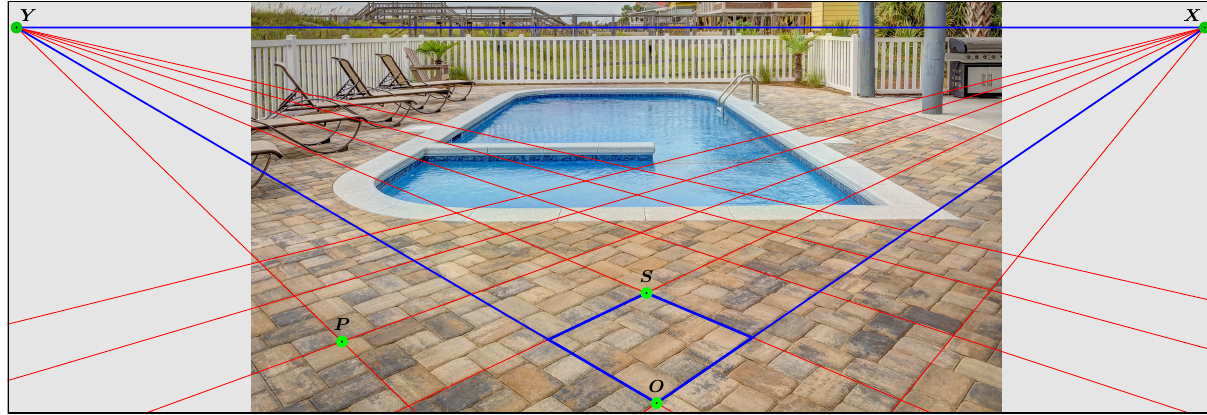
Figure 3. Pool and Pavement (Photo by GregoryButler, 2013). Vanishing points X and Y are estimated by the joints in the pavement. O and S are arbitrary chosen and define the origin and unit square. The position of an arbitrary point P on the ground plane can be found by the barycentric ratio ( X , Y , O ; S , P )